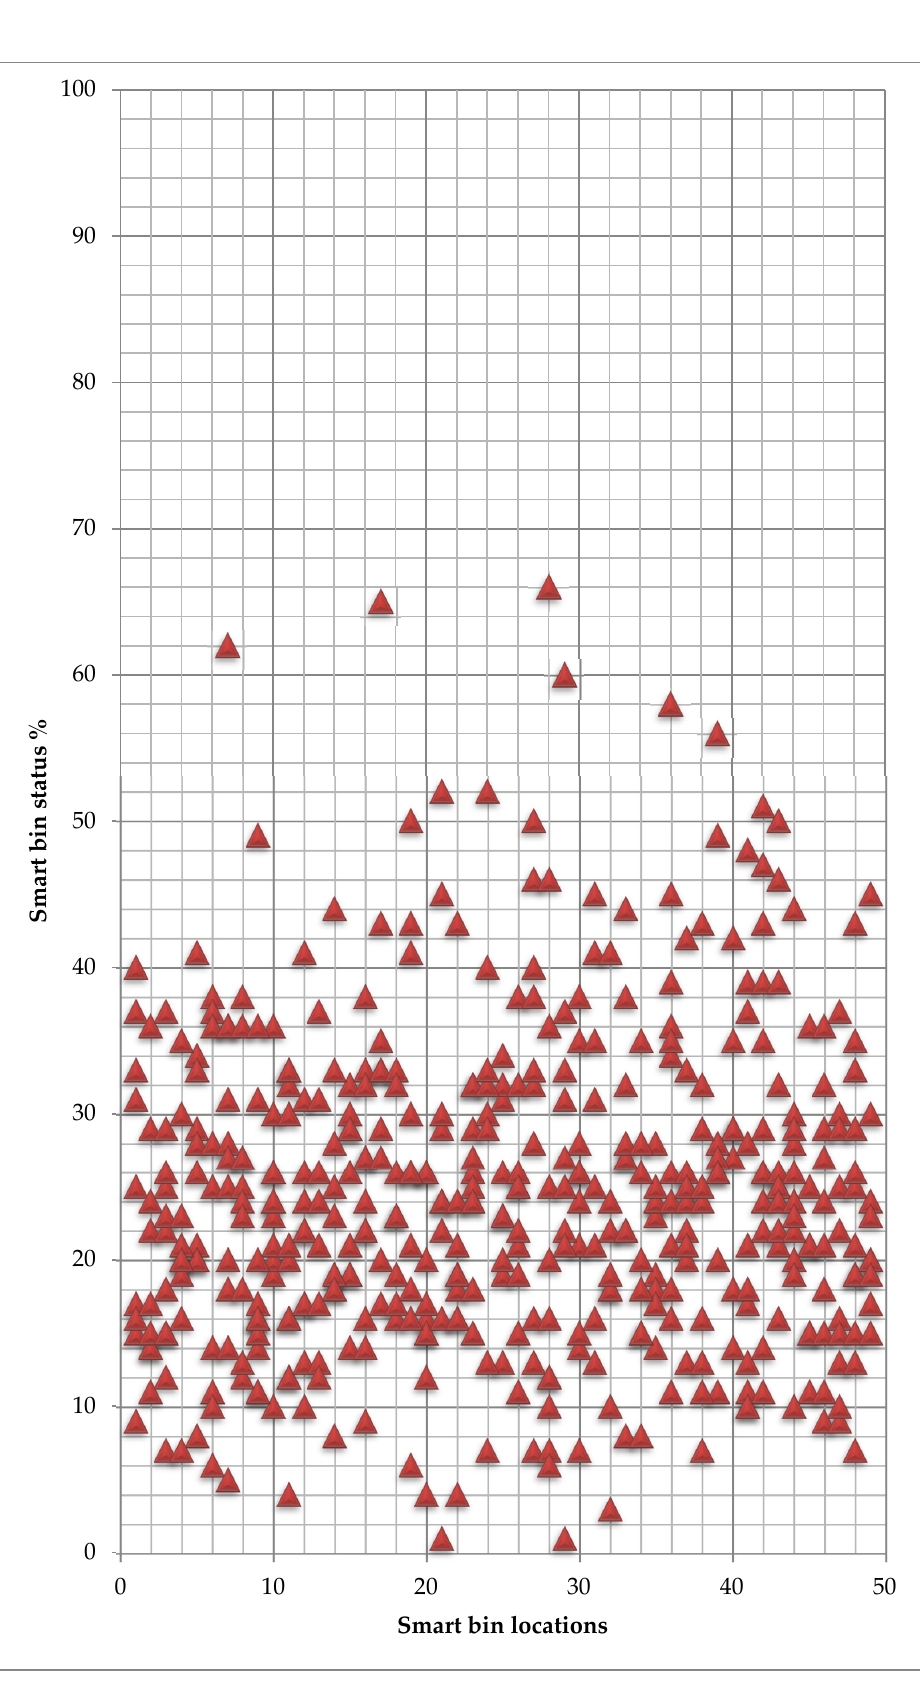
Figure 20. Smart bin status towards each smart bin location-Type 3.